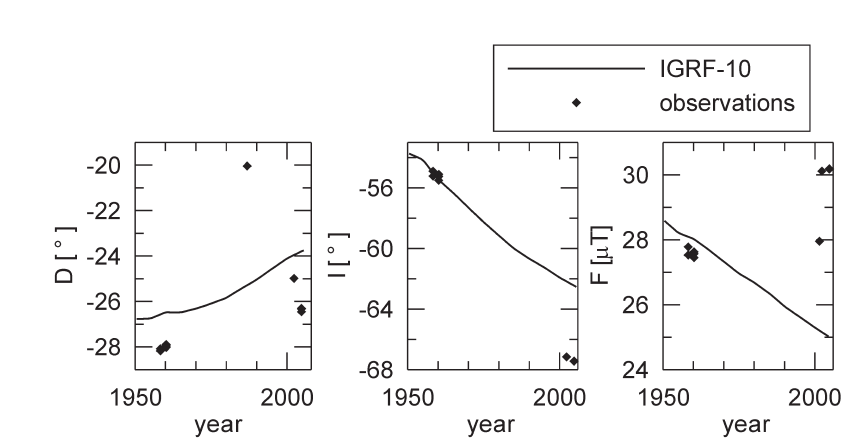
Fig. 3. Comparison of repeat station measurements on Tristan da Cunha with IGRF-10 (Maus et al. , 2005). The large scatter of the observations is due to several relocations of the repeat station (see text and table I) in the pres- ence of large spatial gradients of the crustal